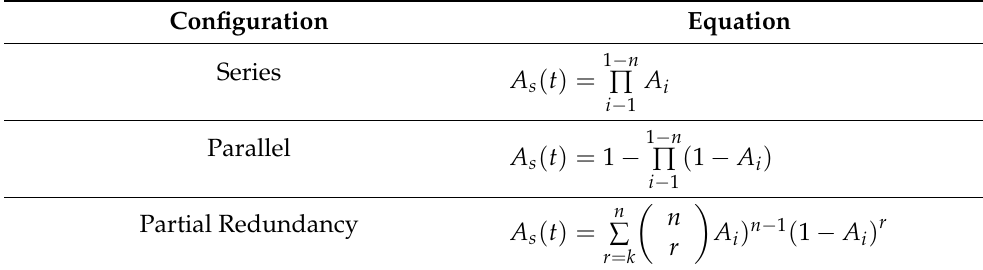
Table 1. Availability metrics according to different system topologies.